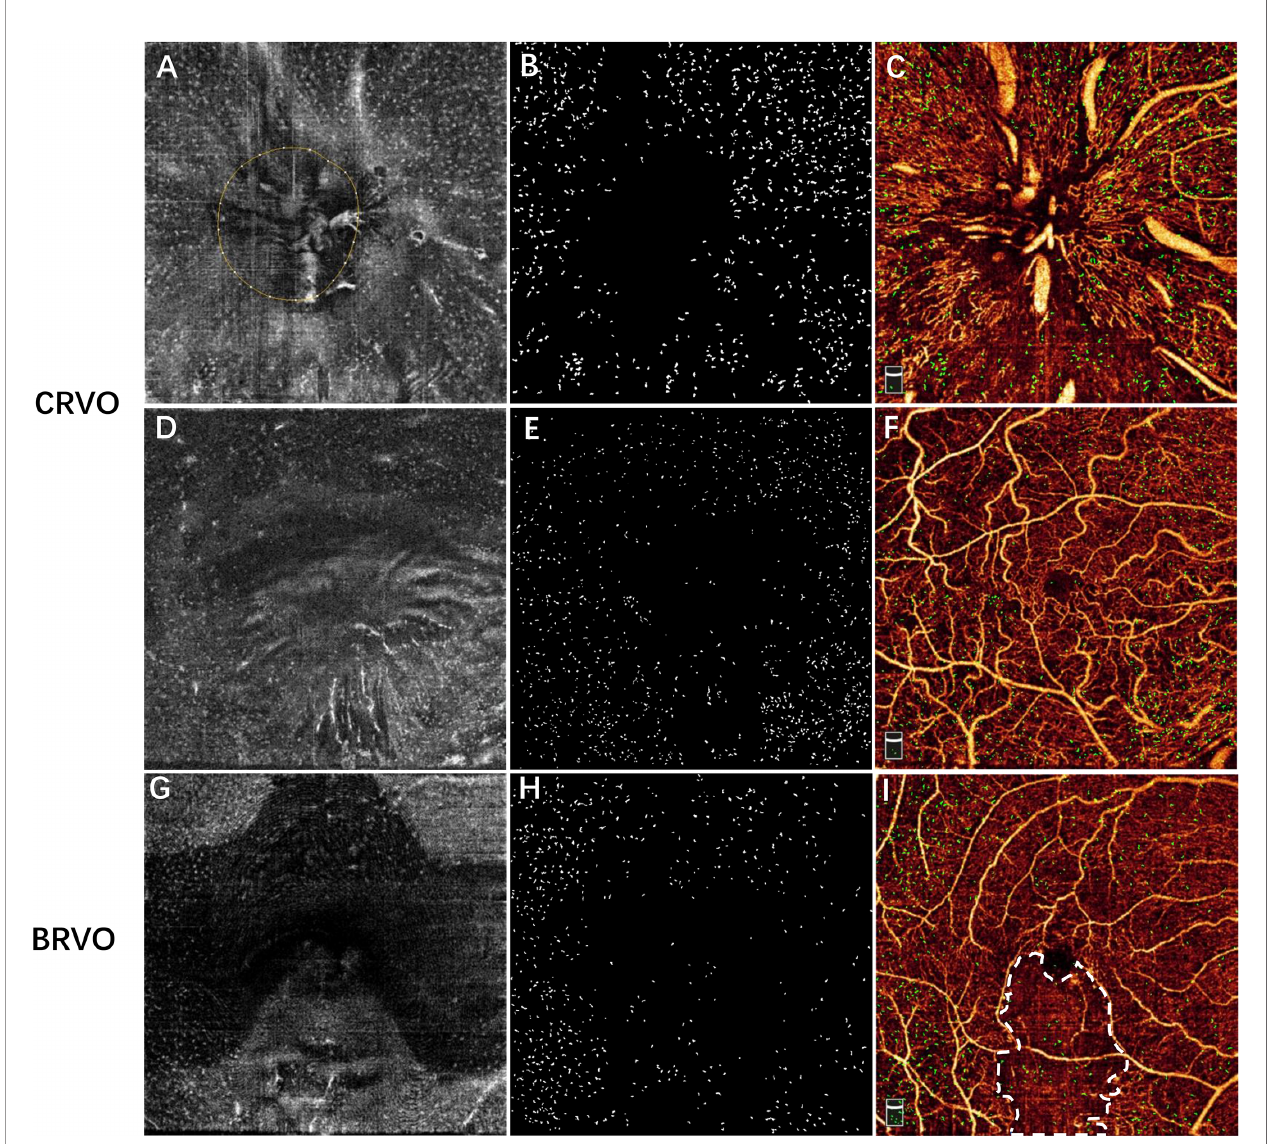
FIGURE 3 | Examples showing the distribution of MLCs relative to the vessels in a patient with CRVO (A – F) and a patient with inferotemporal BRVO (G – I) . The fi rst row shows the images of the ONH region, and the second and third rows show the images of macular region. (A, D, G) The 3- m m en face OCT slab showing macrophage-like cells. (B, E, H) Subtracted and enhanced MLCs. (C, F, I) Overlay of vascular network and macrophage-like cells (green). (I) En face OCTA image showing the non-perfused region (region inside white dash). Note that MLCs were sparse in the central macular and non-perfused regions of RVO eye. MLCs, macrophage-like cells; CRVO, central retinal vein occlusion; BRVO, branch retinal vein occlusion; ONH, optic nerve head; OCT, optical coherence tomography; OCTA, optical coherence